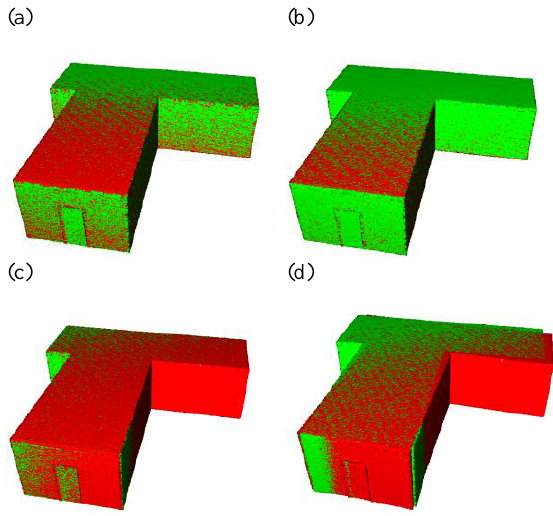
Figure 3 . Visualization of models registered with transformation parameters sorted in ascending order from (a) to (d) according to respective